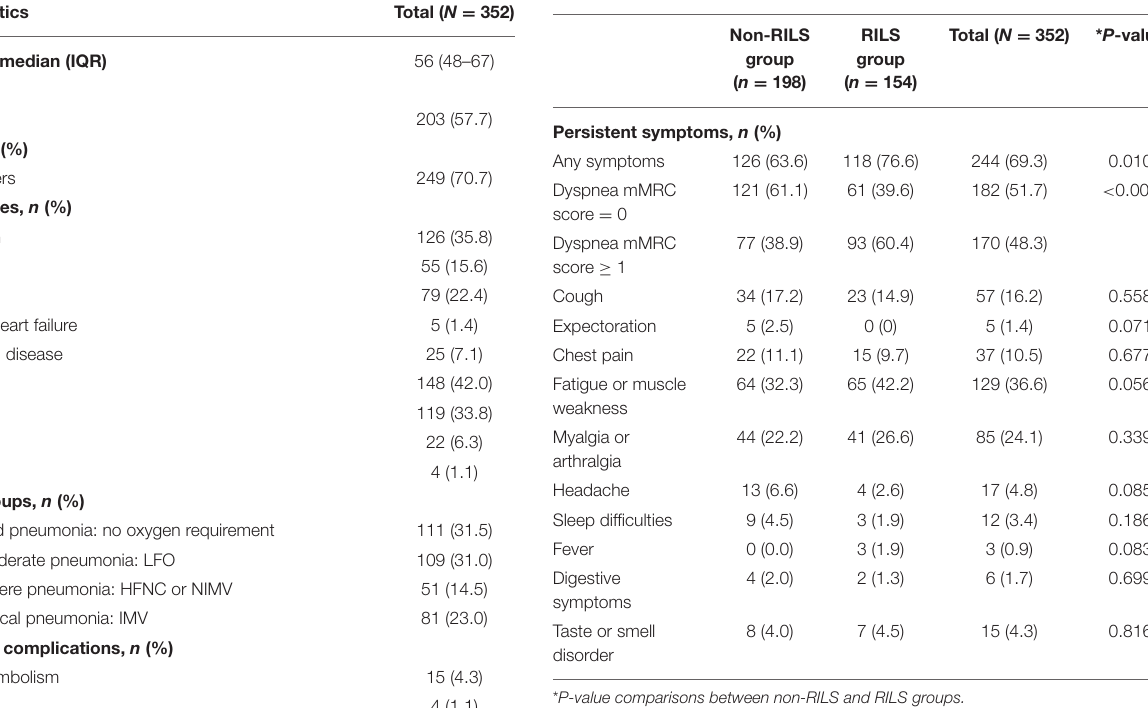
TABLE 3 | Persistent symptoms at follow-up in relevant interstitial lung sequelae (RILS) groups classified by the Warrick score. Non-RILS